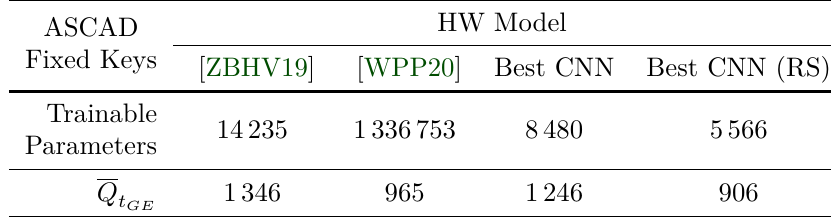
Table 2: Comparison of the top generated CNNs for the ASCAD with a fixed key HW leakage model experiments with the current state-of-the-art.